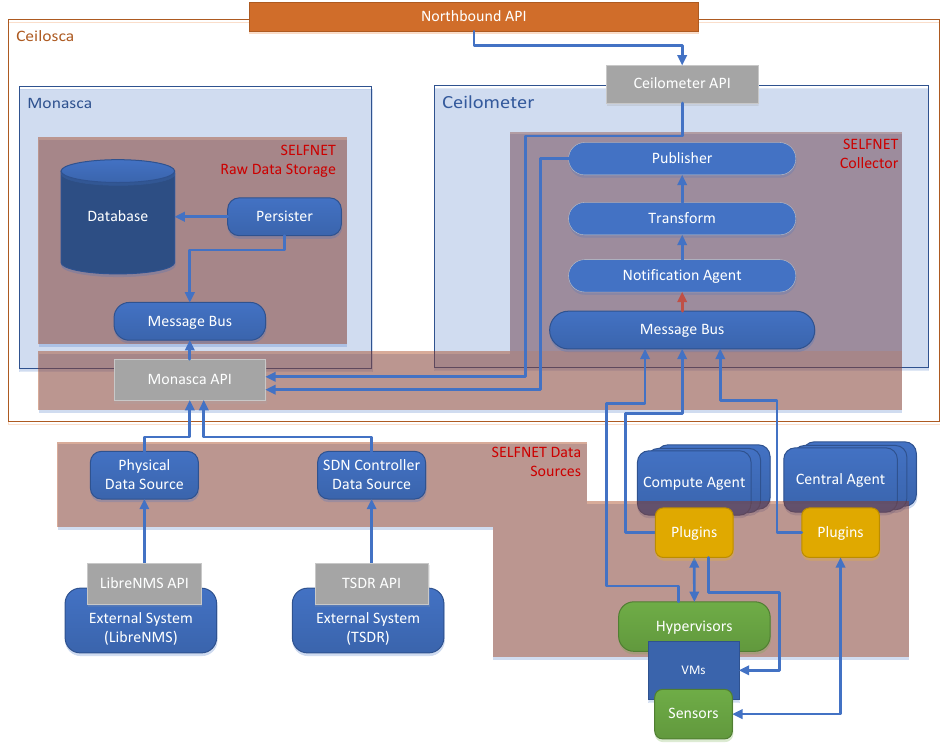
Figure 14. Mapping between Ceilosca and SELFNET Monitoring Framework.